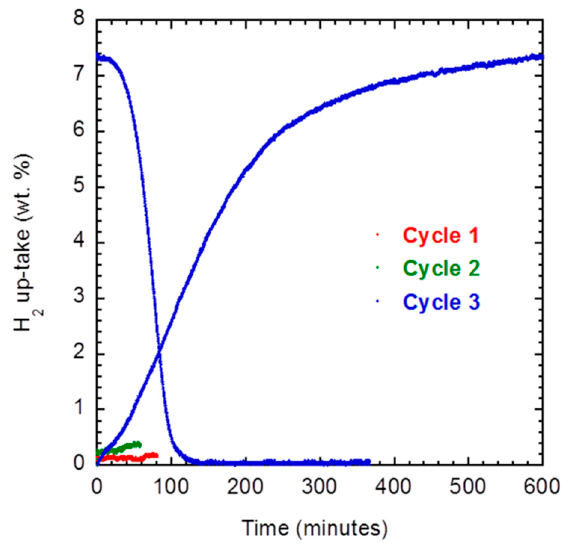
Figure 3. Hydrogen sorption kinetics recorded on a pure Mg sample forged at room temperature. Hydrogen pressure cycles are applied at 360 °C, with respectively 2MPa and 150 kPa for absorption and desorption steps.